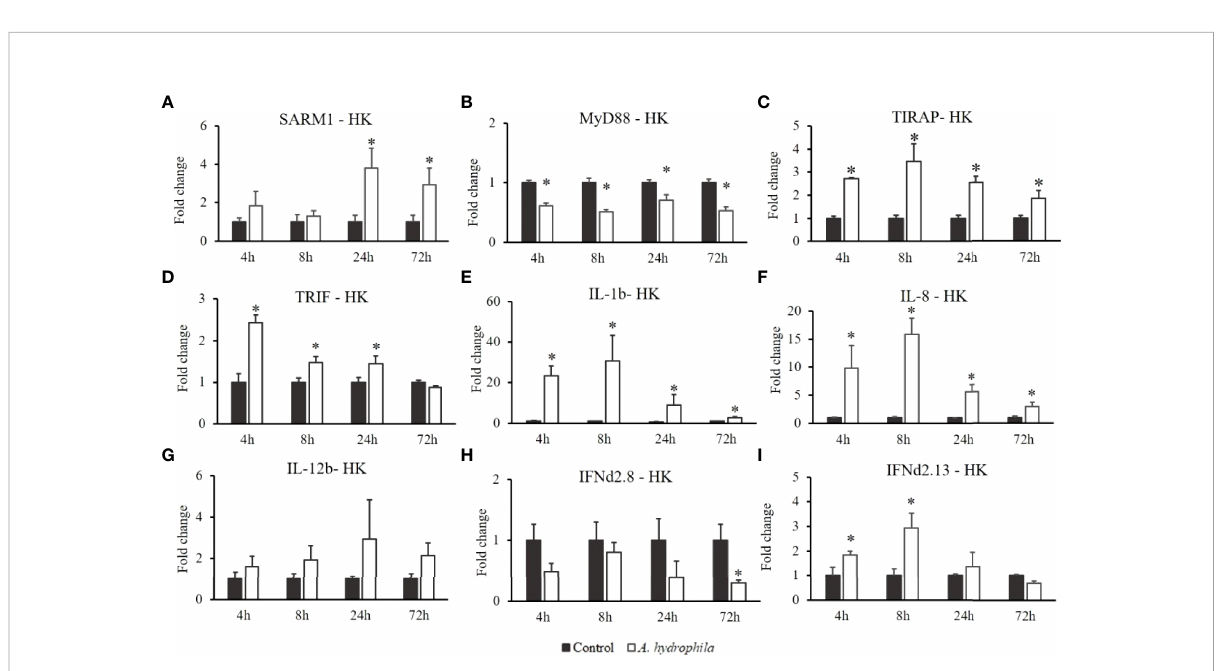
FIGURE 8 Gene expression of (A) SARM1 , (B) MyD88 , (C) TIRAP , (D) TRIF , (E) IL-1 b , (F) IL-8 , (G) IL-12b , (H) IFNd2.8 , and (I) IFNd2.13 in the head kidney from Oreochromis niloticus challenged with Aeromonas hydrophila . Expression of the indicated genes was normalized to the expression level of EF-1 a and expressed as fold change relative to the control group. The values are shown as mean + SD (n = 3). Signi fi cant differences from the control group at each time point are indicated by asterisks (P < 0.05, unpaired sample